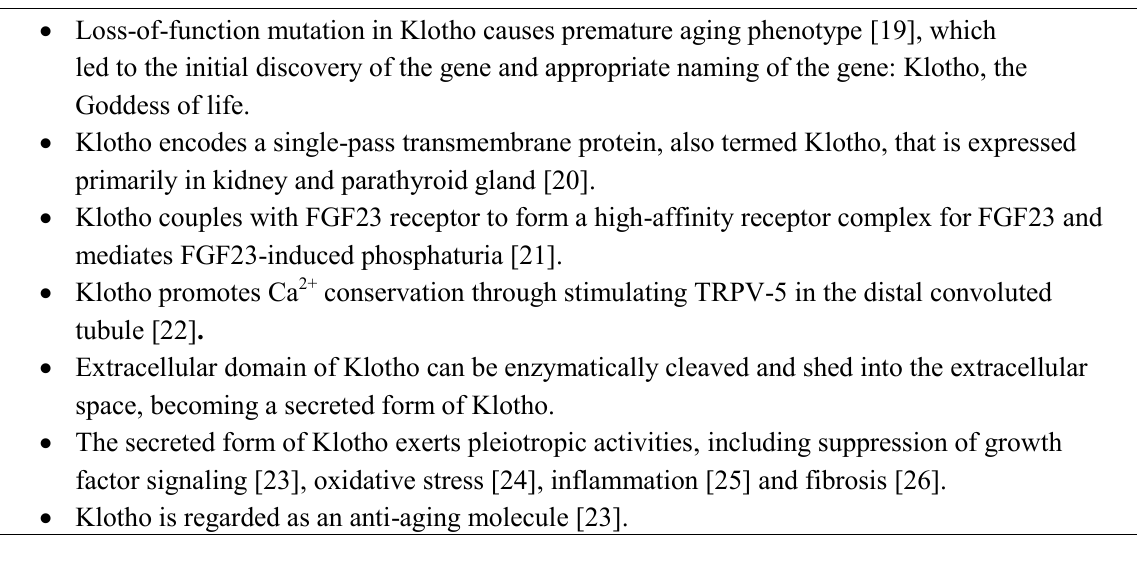
Table 1. The Kidney Disease Outcomes Quality Initiative (KDOQI)—(2002) definition of CKD. GFR, glomerular filtration